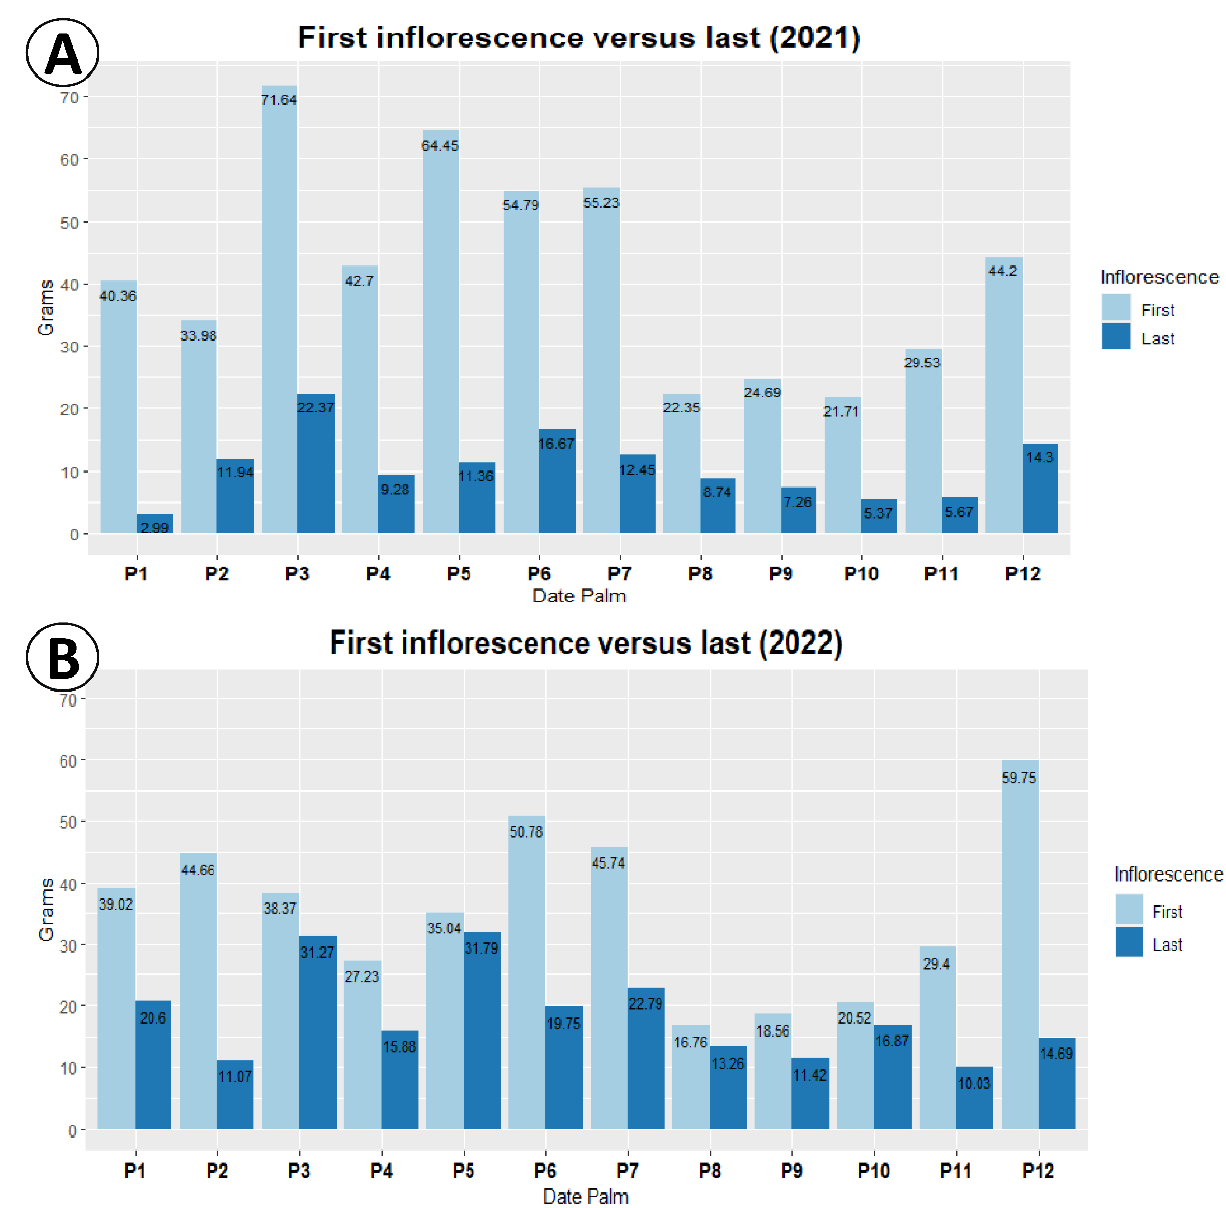
Figure 4. Pollen production of the first inflorescence in each palm, versus the pollen production of the last inflorescence in the same palm. ( A ) Comparison of pollen production of the first inflorescence versus the last one in the year 2021. ( B ) Comparison of pollen production of the first inflorescence versus the last one in the year 2022.